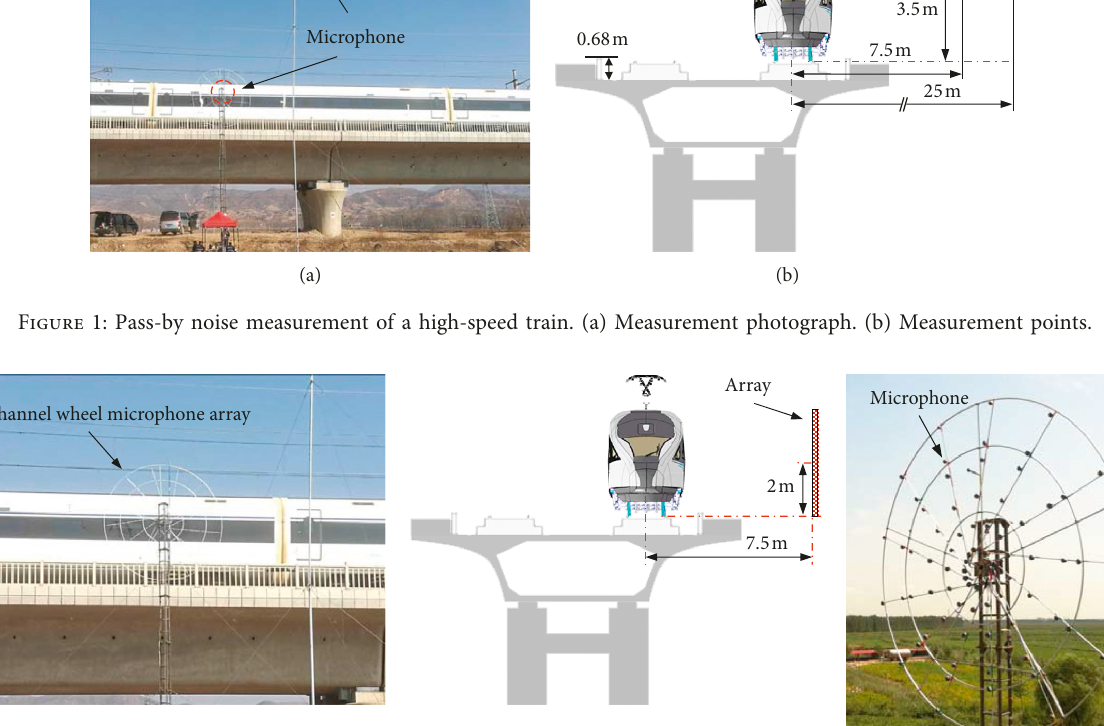
Figure 2: Noise source identification of a high-speed train. (a) Measurement photograph. (b) Measurement points. (c) 78-channel wheel microphone array (B&K